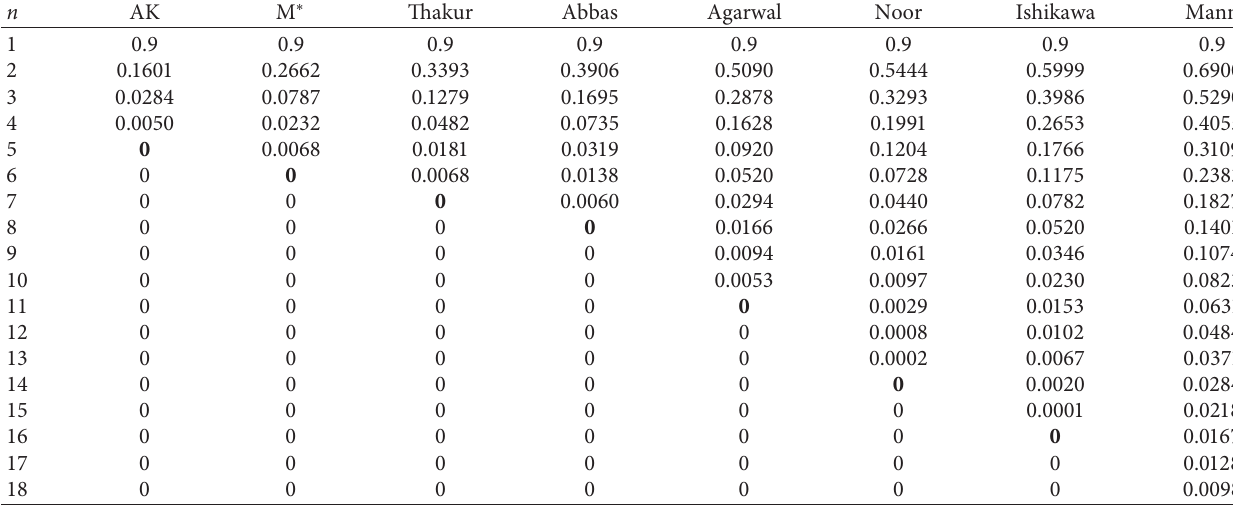
Table 1: Computation table obtained from the AK, M ∗ , Thakur, Abbas, Agarwal, Noor, Ishikawa, and Mann iteration process using Example